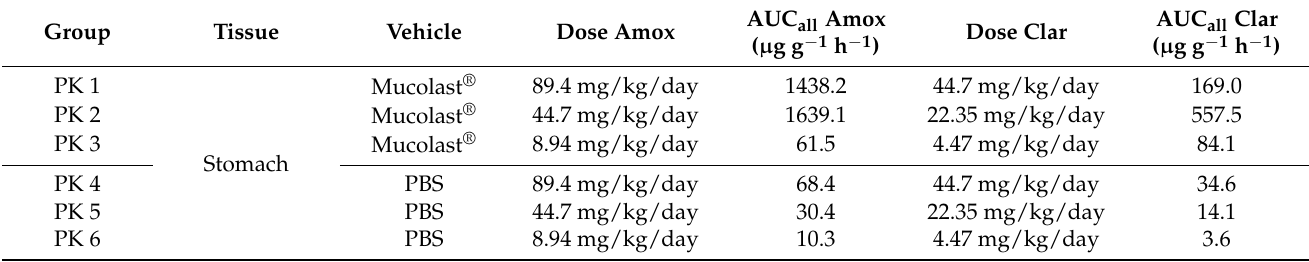
Figure 4. Amox and Clar stomach levels after the administration of antibiotics in Mucolast ® or saline solution at three different doses. Table 7. Amox and Clar AUC stomach values after the administration of antibiotics in Mucolast ® or saline solution at three different